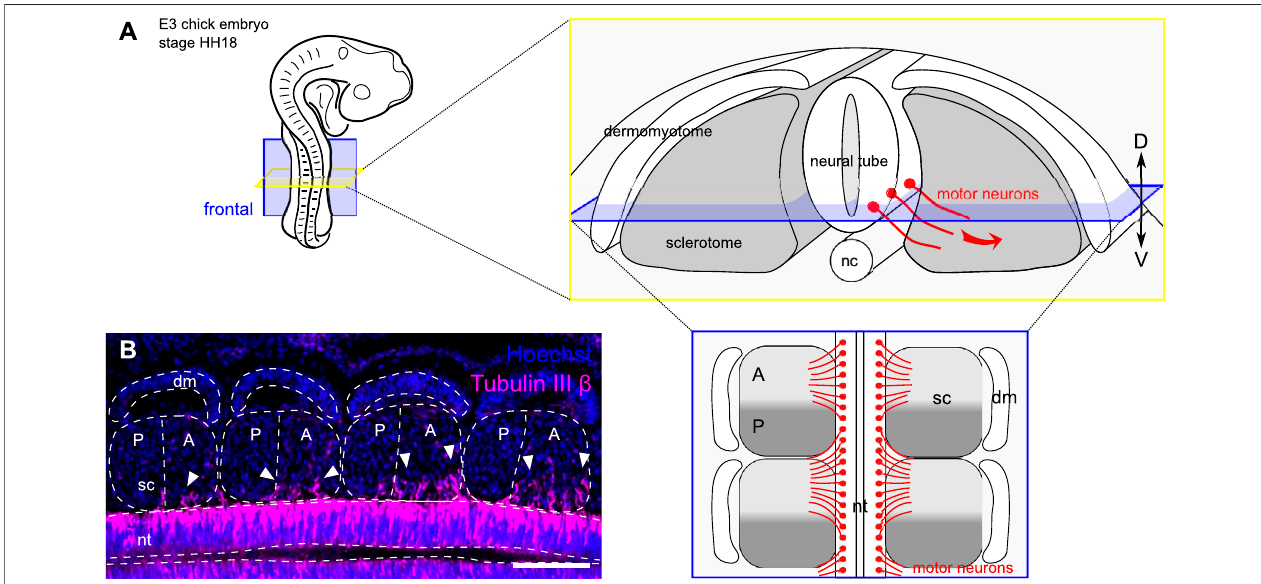
FIGURE 1 | Motor axons grow out of the neural tube in a segmented fashion. (A) Schematic representation of the developing peripheral nervous system in chick embryo embryonic day 3 (E3),stage HH18. Motor neurons project their axon out ofthe neural tube, in the sclerotome,alonga ventral-lateral trajectory. The frontal plane (inblue)isusedtostudysegmentationofoutgrowingmotoraxons.(D)dorsal;V:ventral. (B) Immunohistochemistryonafrontalsectionofachickembryoshowingmotor axons (Tubulin III β , red) growing out of the neural tube (nt) and cell nuclei (Hoechst, blue) in somite segments. Scale bar = 100 μ m dm: dermomyotome; sc: sclerotome; nc: